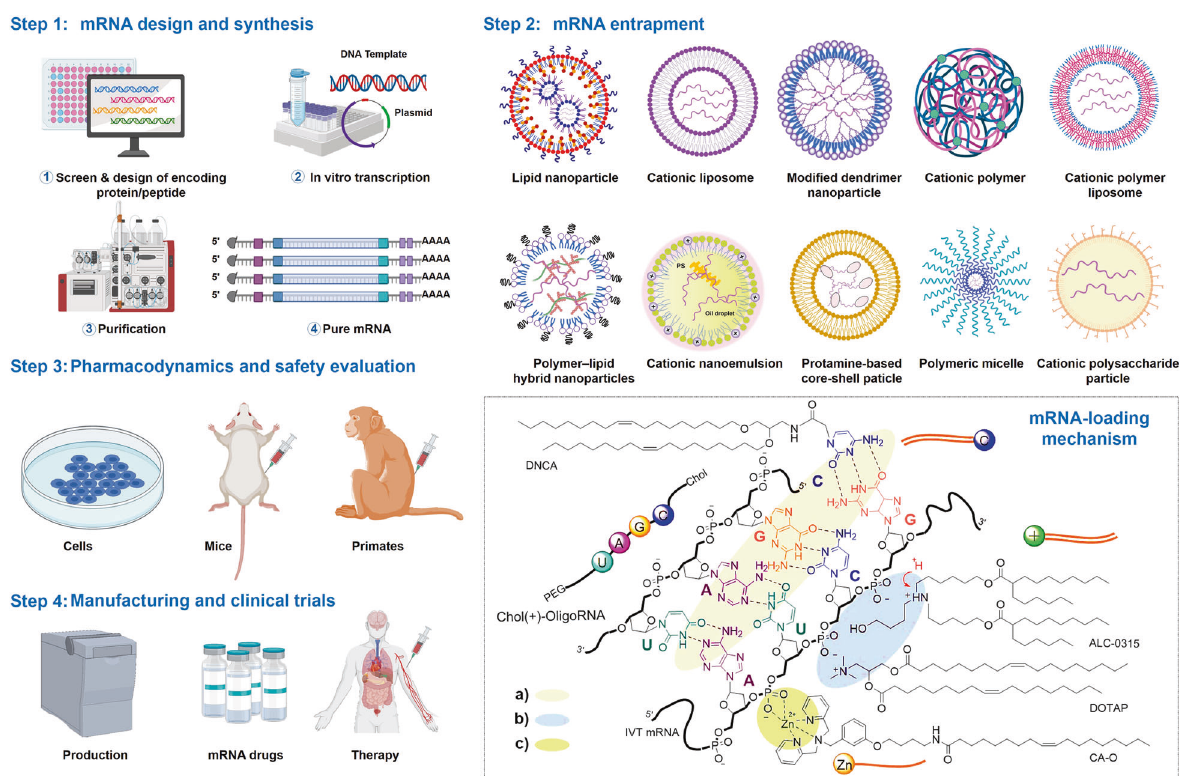
Fig. 2 mRNA drugs production pipeline. The encoding of peptide/protein is designed and inserted into a plasmid DNA construct. Plasmid DNA is transcribed into mRNA by bacteriophage polymerases in vitro, and mRNA transcripts are puri fi ed by high-performance liquid chromatography (HPLC) or nanoprecipitation to remove contaminants and reactants. Subsequently, puri fi ed mRNA is entrapped in various vehicles. The interactions between vehicles and mRNA can be divided into three types: (a) electrostatic adsorption with phosphate ions of